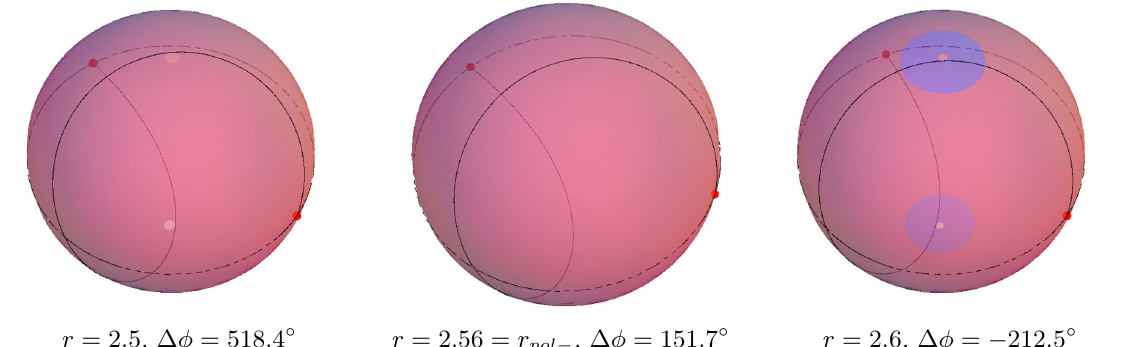
at r > r pol − , however, there is not zero nodal shift at r = r pol − . The jump of the shift is a simple consequence of a singular behaviour of the φ - coordinate at the poles θ = 0